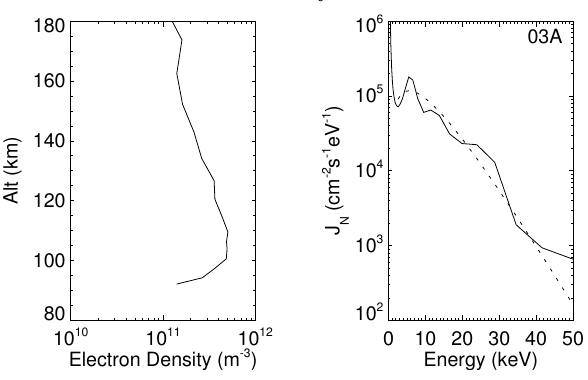
Fig. 8. The same as Fig. 7 but for events 02C and 03A.